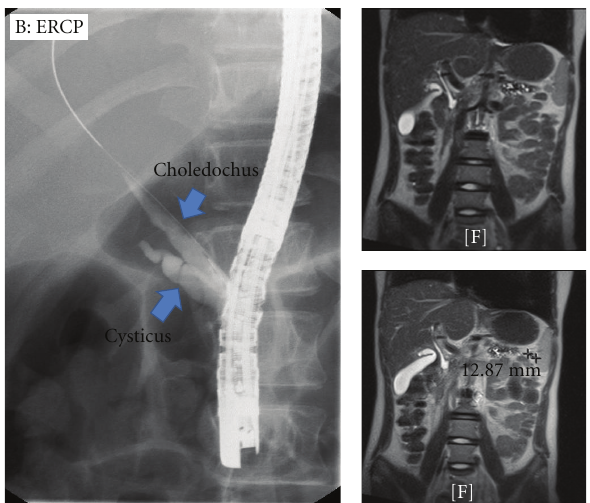
Figure 2: A: MRCP images demonstrating normalisation of the biliary tree after removal of the stent. B: ERCP image from choledochus after stent